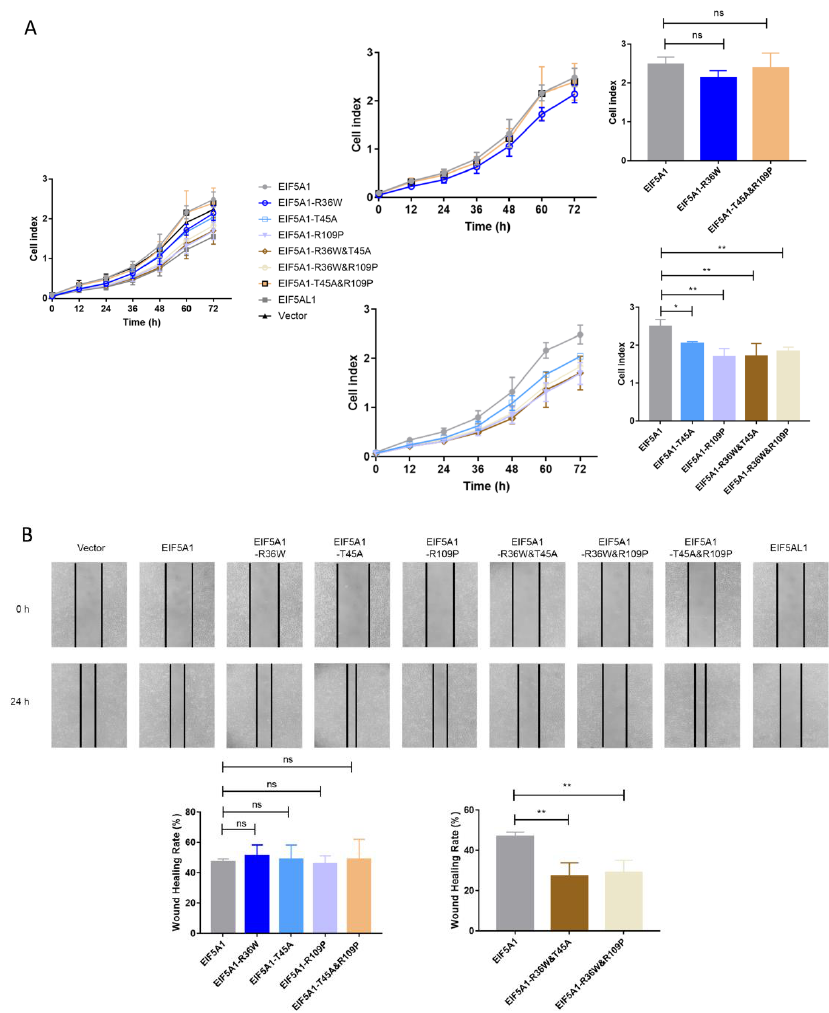
Figure 4. Overexpression of EIF5A1 mutants had different effects on HeLa cell proliferation and migration. After transfecting and expressing EIF5A1, EIF5AL1, EIF5A1 mutant, and vector plasmids in HeLa cells, respectively. ( A ) HeLa cells were seeded on 16-well E-plates with 3.0 × 10 3 cells in each well and incubated in a cell incubator for 72 h, and tested for cell index values over time. ( B ) HeLa cells were seeded into 12-well plates with 3.0 × 10 5 cells per well for 24 h, and then, a wound healing assay was performed. ns, p > 0.05; *, p ≤ 0.05; **, p ≤